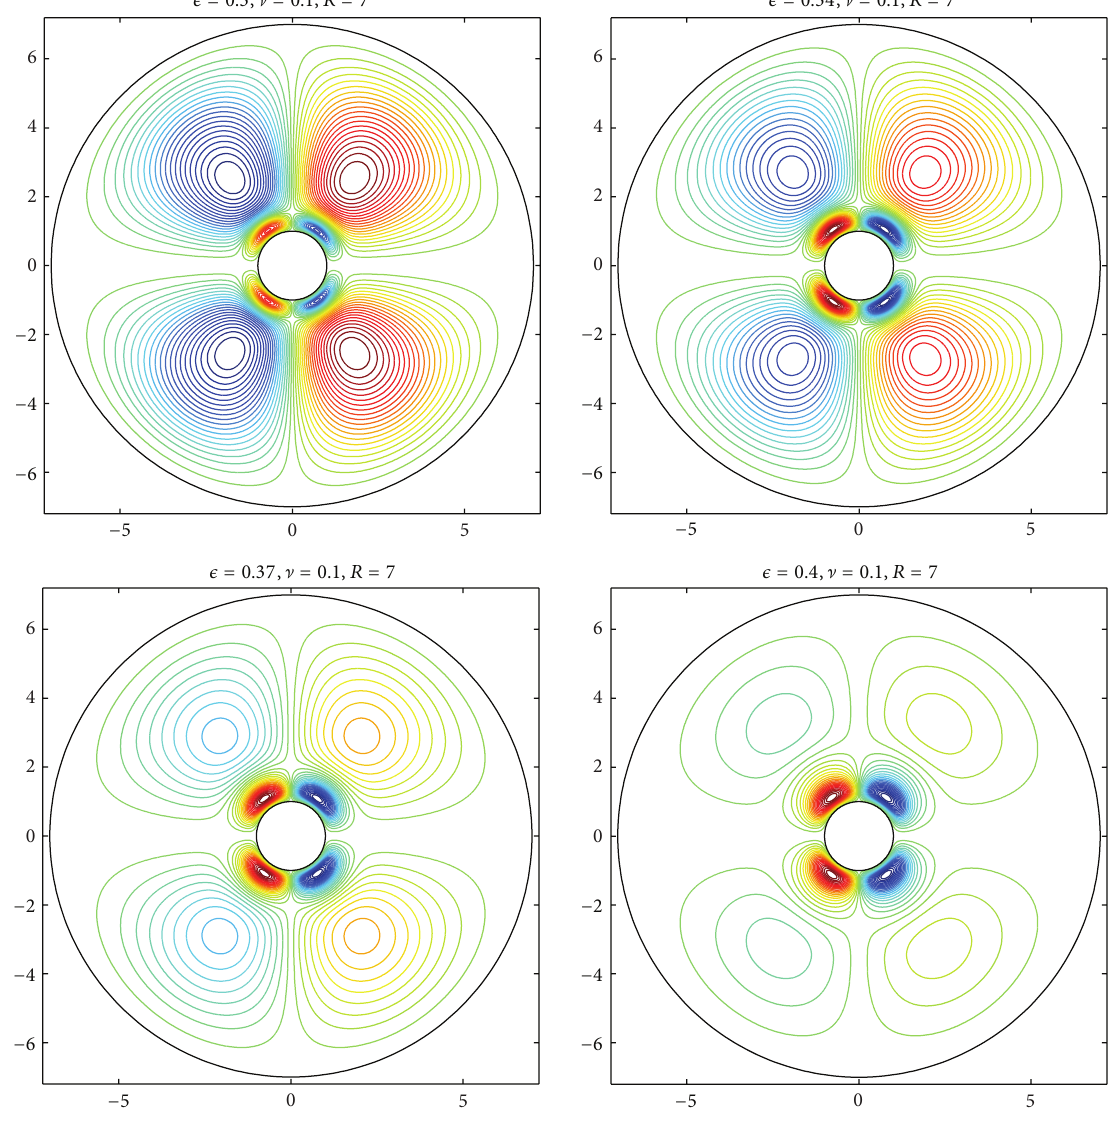
Figure 4: Steady streaming between two